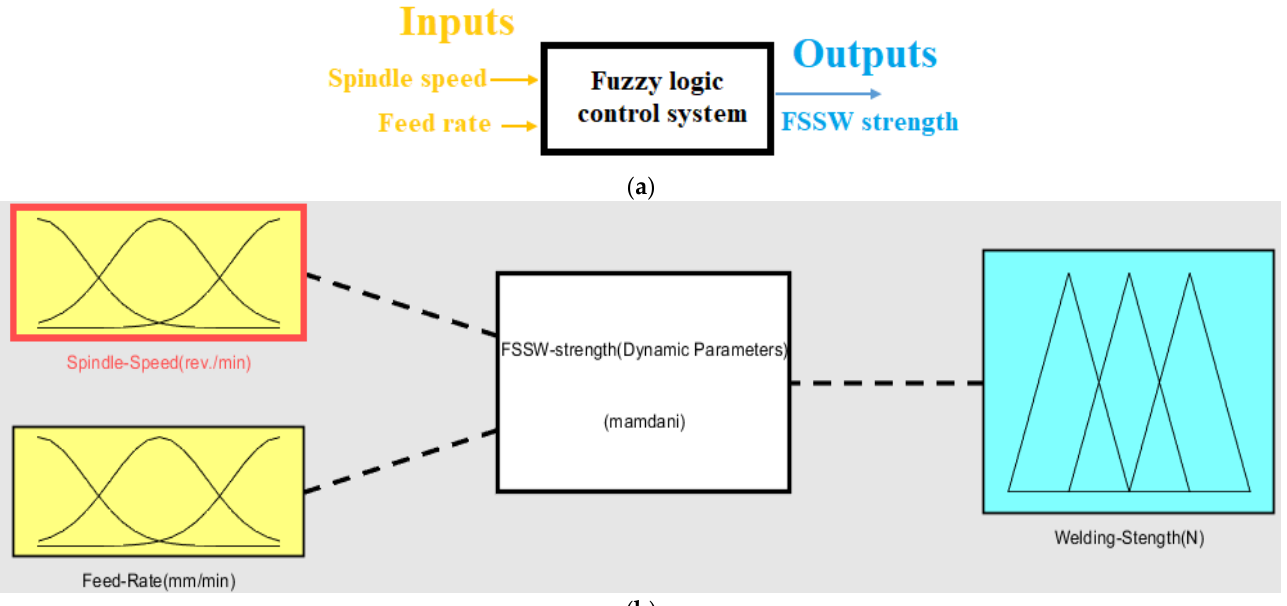
Figure 14. FSSW strength (dynamic parameters) fuzzy logic control system ( a ) inputs and outputs ( b ) Mamdani FLCS.